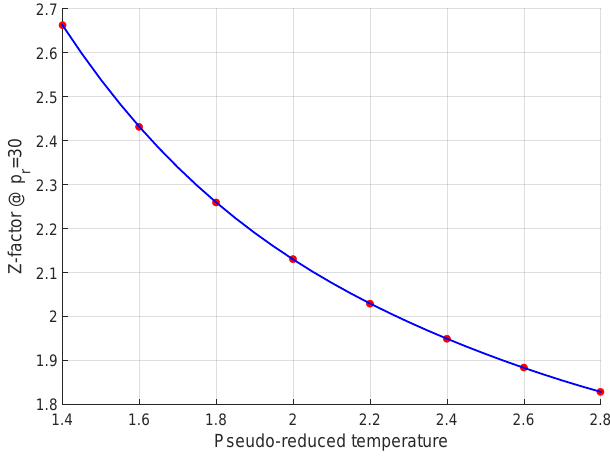
Figure 6. Z factor values at p r = 30 for various T r